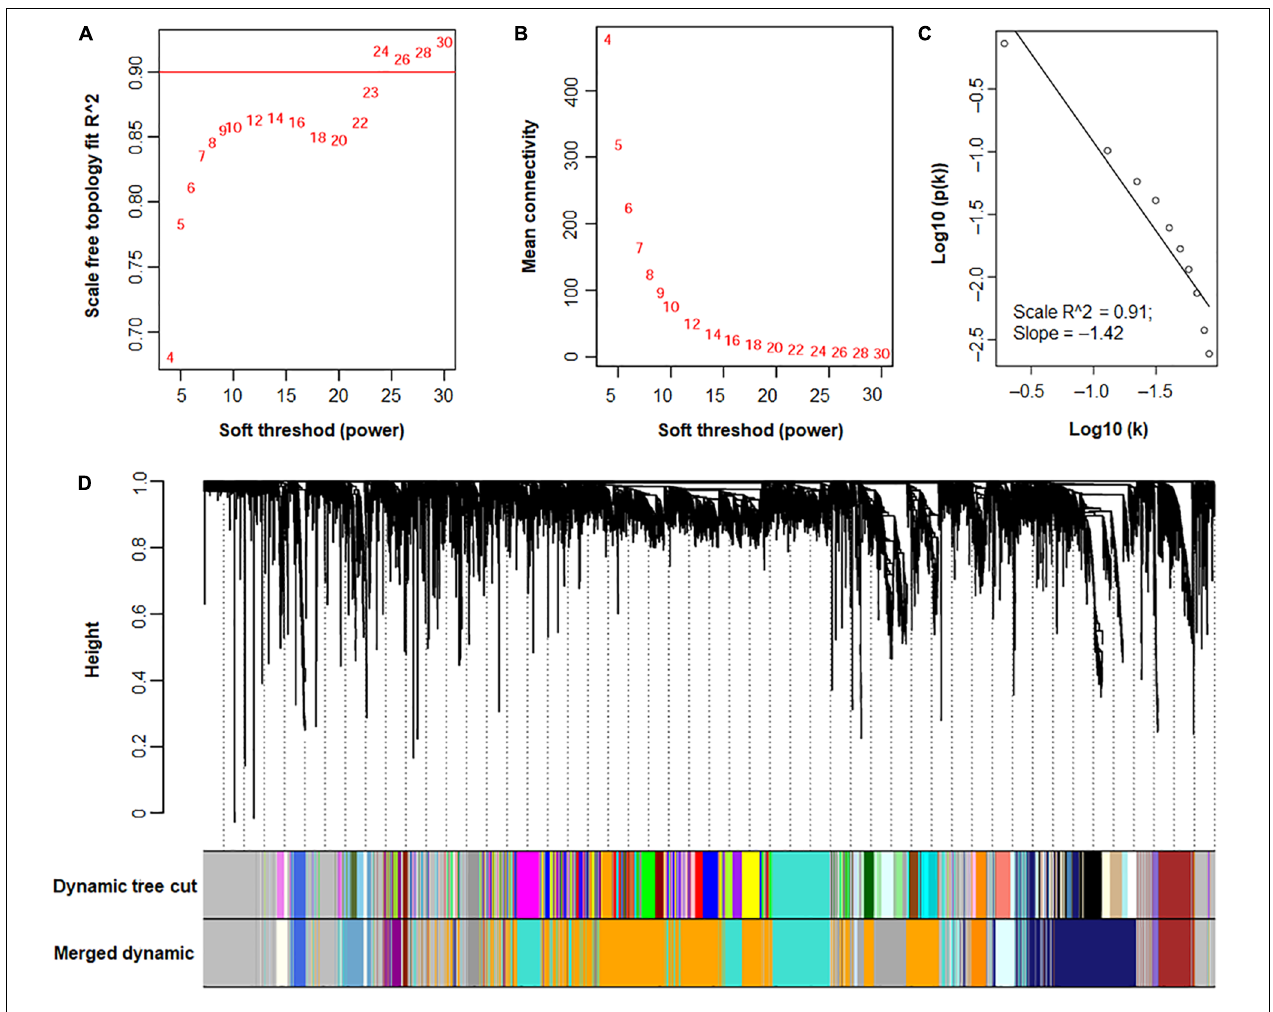
FIGURE 7 | A WGCNA of transcriptomes from P. oxalicum under different culture conditions. (A) Determination of soft-power based on the adjacency matrix. (B) Mean connectivity. (C) Confirmation of scale-free topology. Based on (A–C) , the soft-powder was selected as 24, resulting in a scale-free gene co-expression network topology. (D) Identification of functional modules illustrated with various colors. Cluster dendrograms were generated using hierarchical clustering. Original modules were identified using the Dynamic Tree Cutting method, and merged modules were generated according to the correlations of modules, with module dissimilarity coefficients of ≤